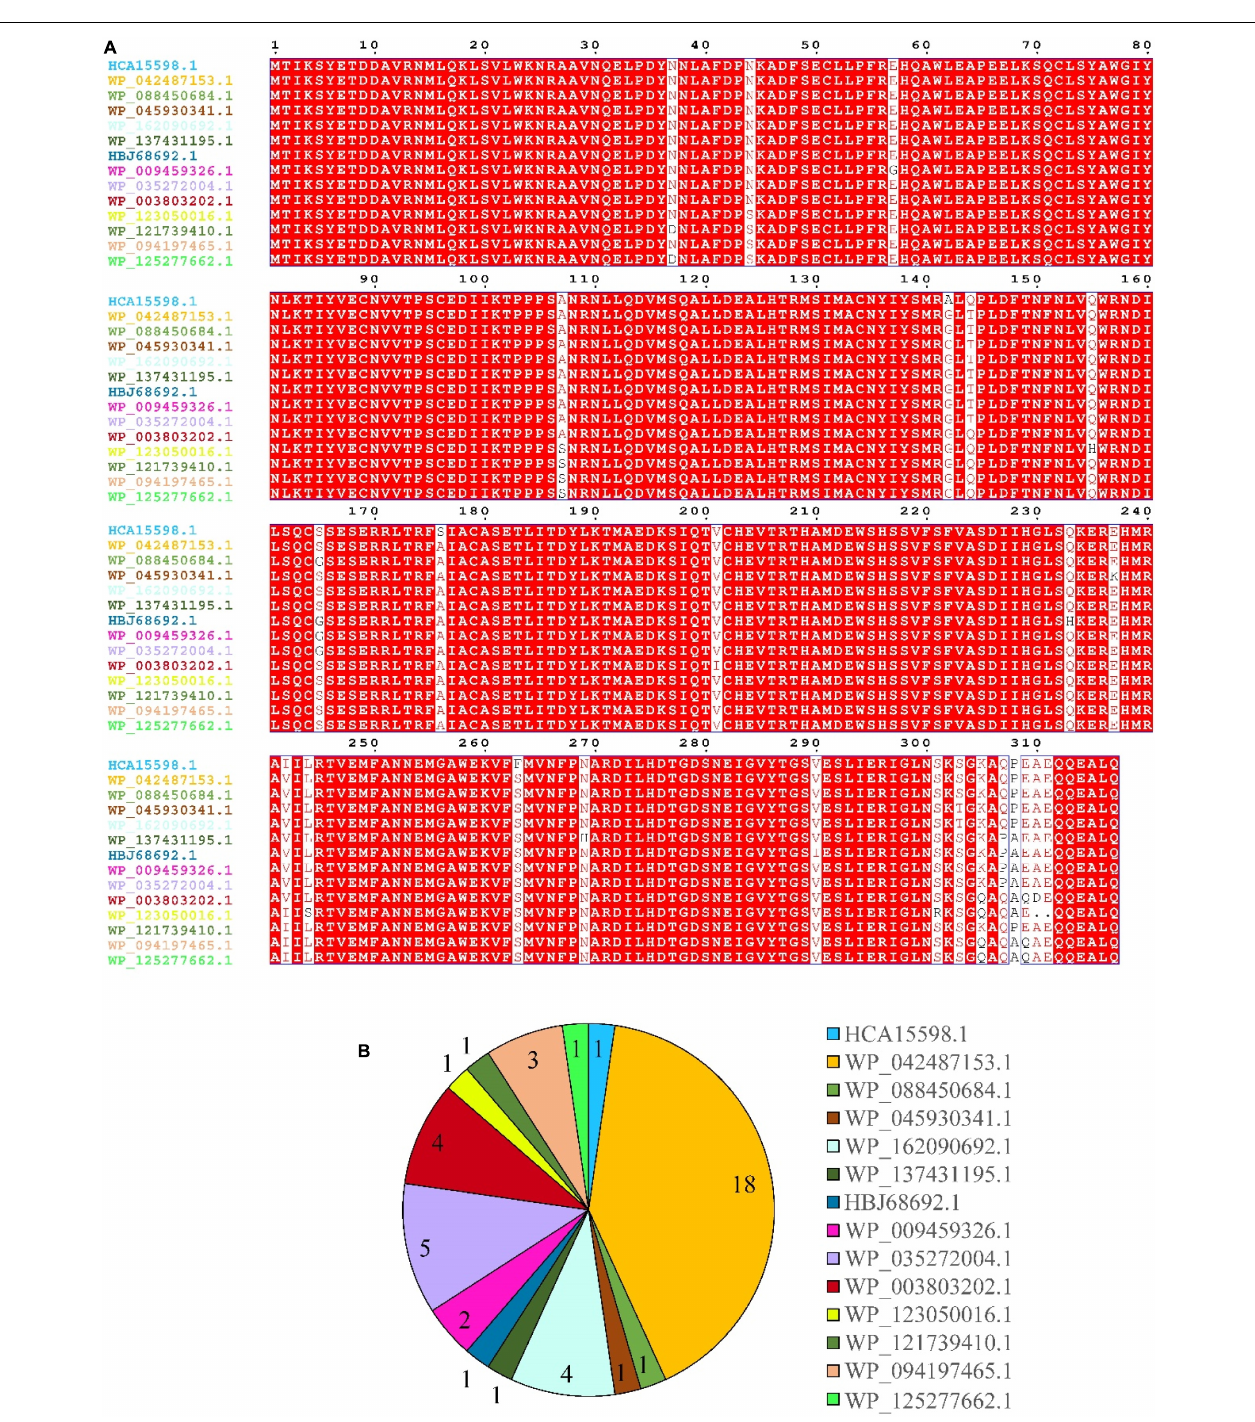
FIGURE 4 | Multiple-sequence alignment (A) and statistics (B) of Alcaligenes DnfAs. Accession numbers of the proteins (DnfAs, or DnfA homologs) are shown. All genomes (49) in Figure 1 were analyzed, and five of them with incomplete DnfA sequence were excluded.